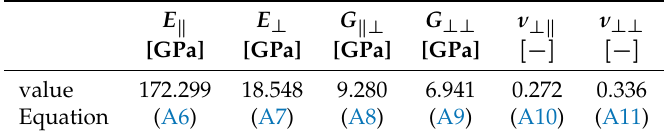
Table 7. Instaneous linear-elastic properties for a transverse isotropic CRFP with an average FVC ¯ φ of 72% (micromechanical semi-analytical solution; Appendix